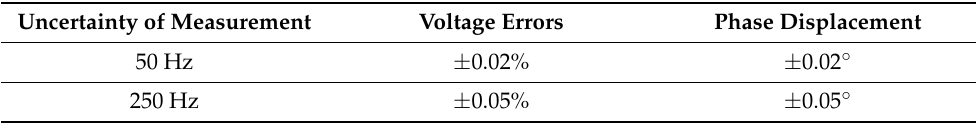
Table 1. Uncertainty of measurement of measuring